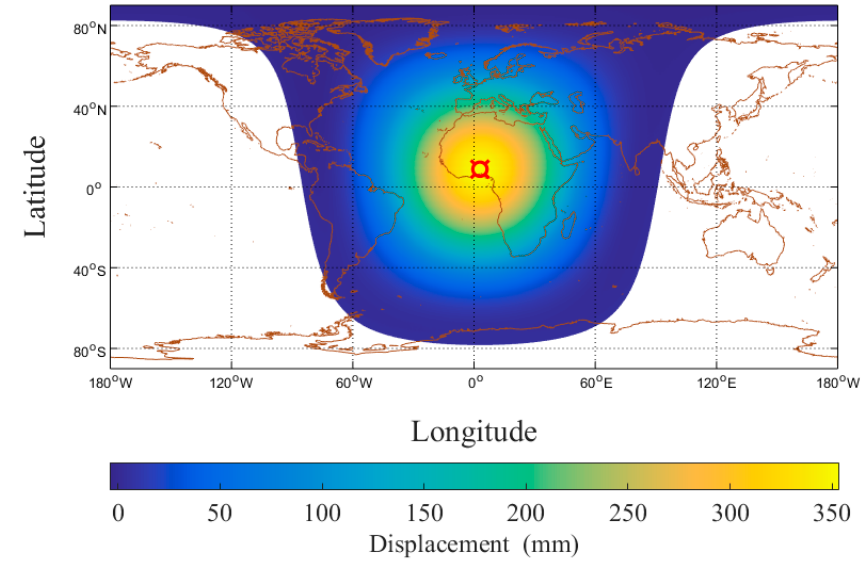
Figure 5. Global displacement distribution in moon direction at 0:00 on 2 March 2018. The image is obtained by masking the projected displacement distribution in the area with a negative lunar altitude angle. The non-displacement area is the absolute blind area of the lunar sensor at that time. The sum of the tidal displacements is distinguished by di ff erent colors, and the red “¤” sign indicates the lunar subpoint.